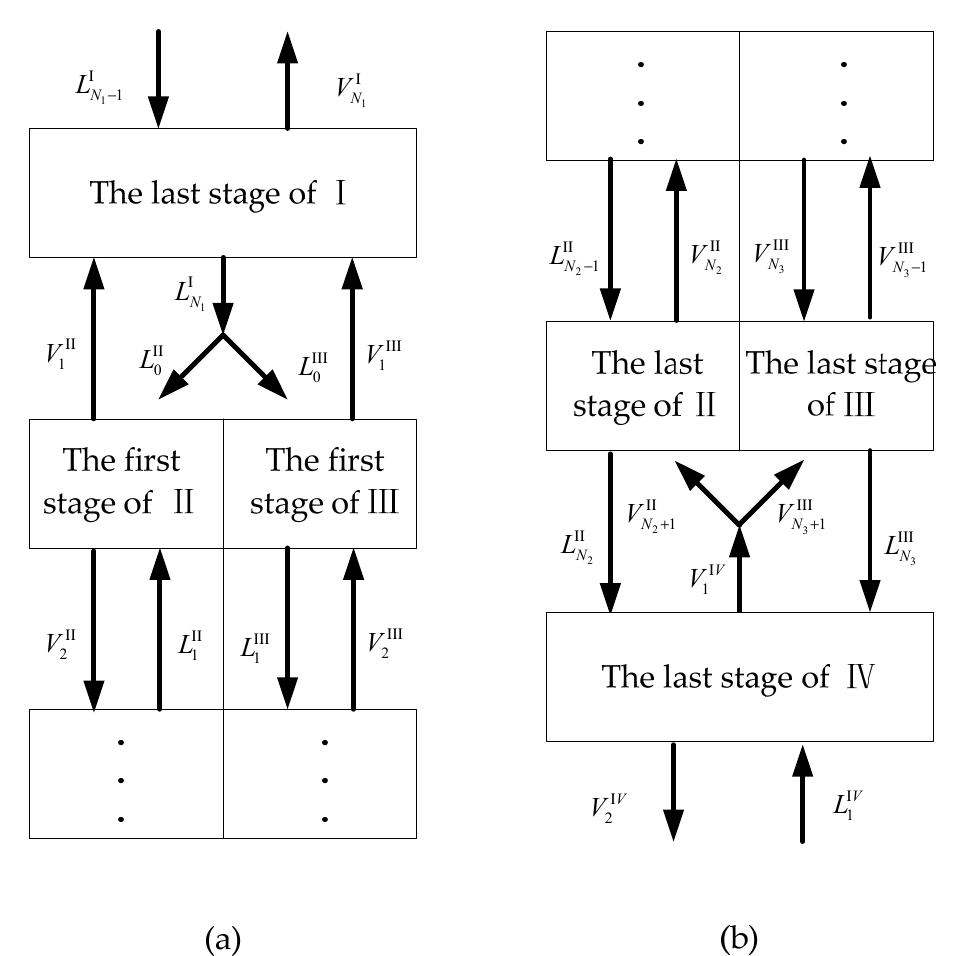
Figure 6. The liquid and vapor splitting and mixing at the specific wall: ( a ) the structure at the top of the column, and ( b ) the structure at the bottom of the column.